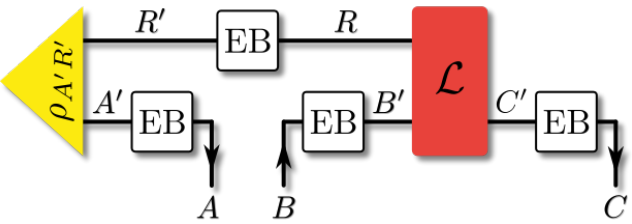
Figure 9: Process with an entanglement breaking map on at least one of its spaces. If the circuit of a process can be represented with an entanglement breaking (EB) channel on one of its wires, then the resulting comb Υ is separable in ABC the corresponding cut. For example, an entanglement breaking channel on the environment R implies that Υ is separable in the splitting A : BC . If there are ABC two entanglement breaking channels (independent of what two wires they act on), then the resulting comb is fully separable. For better tracking of the involved spaces, the input and output spaces of the EB channels are labelled